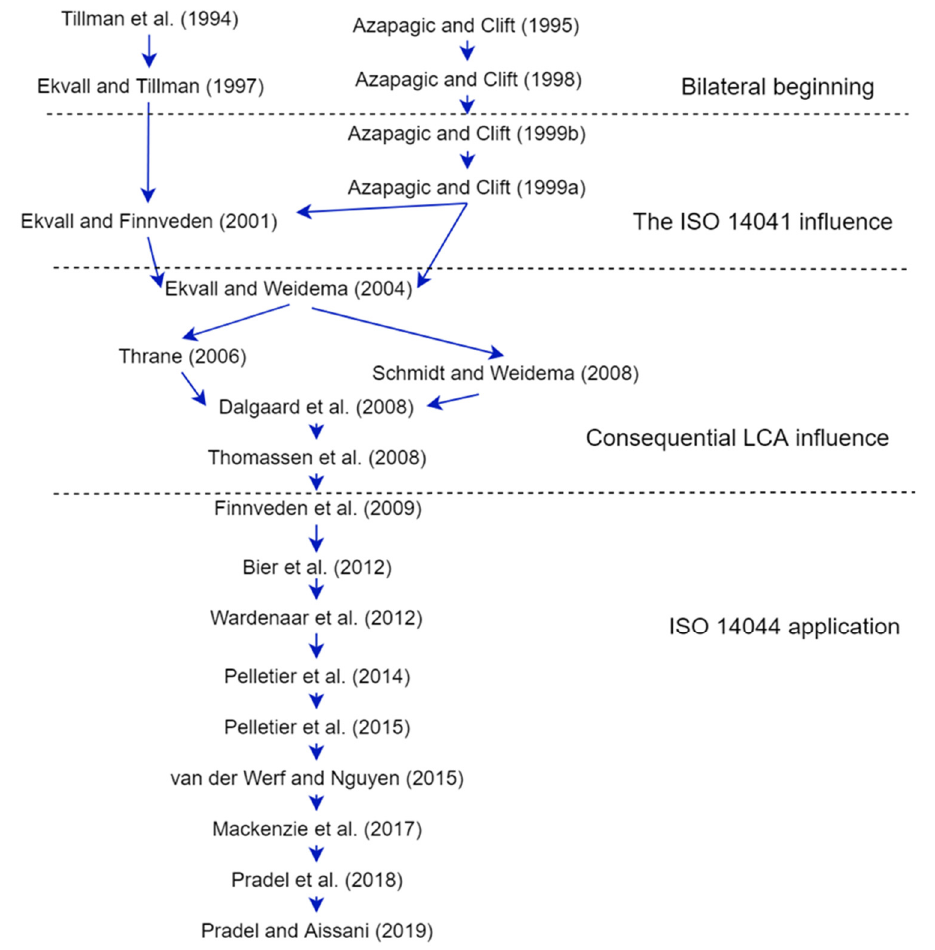
Figure 6. The key-route main path of research on LCA multifunctionality (output from Pajek calculations), obtained from the citation network analysis.